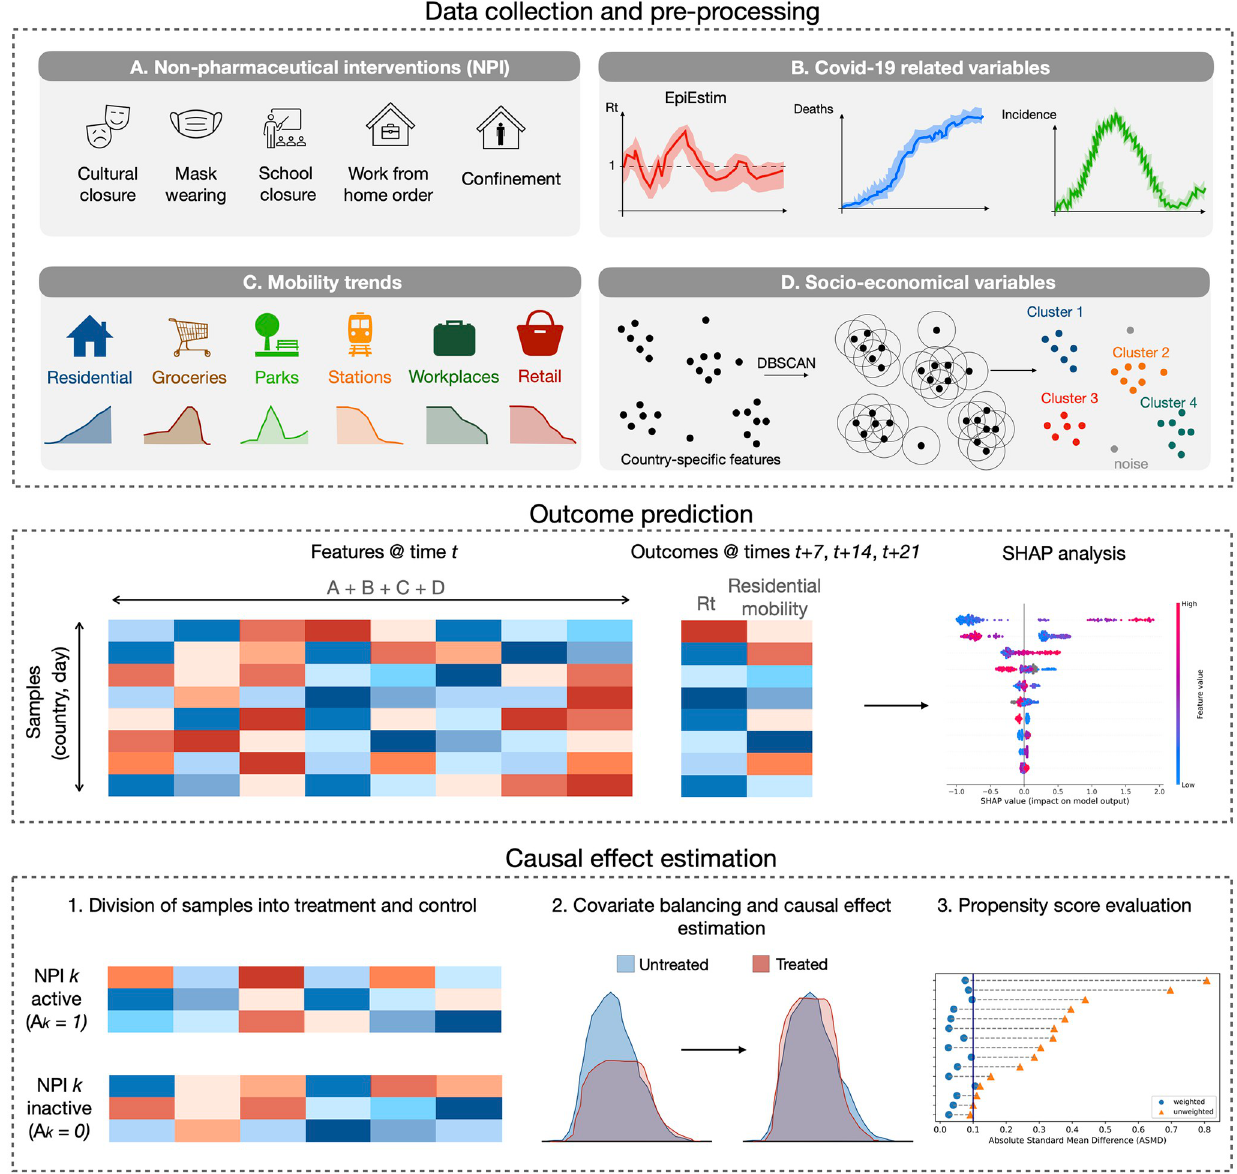
Fig 2. Study workflow. The study can be divided into three main parts: data collection and pre-processing, outcome prediction and causal effect estimation.